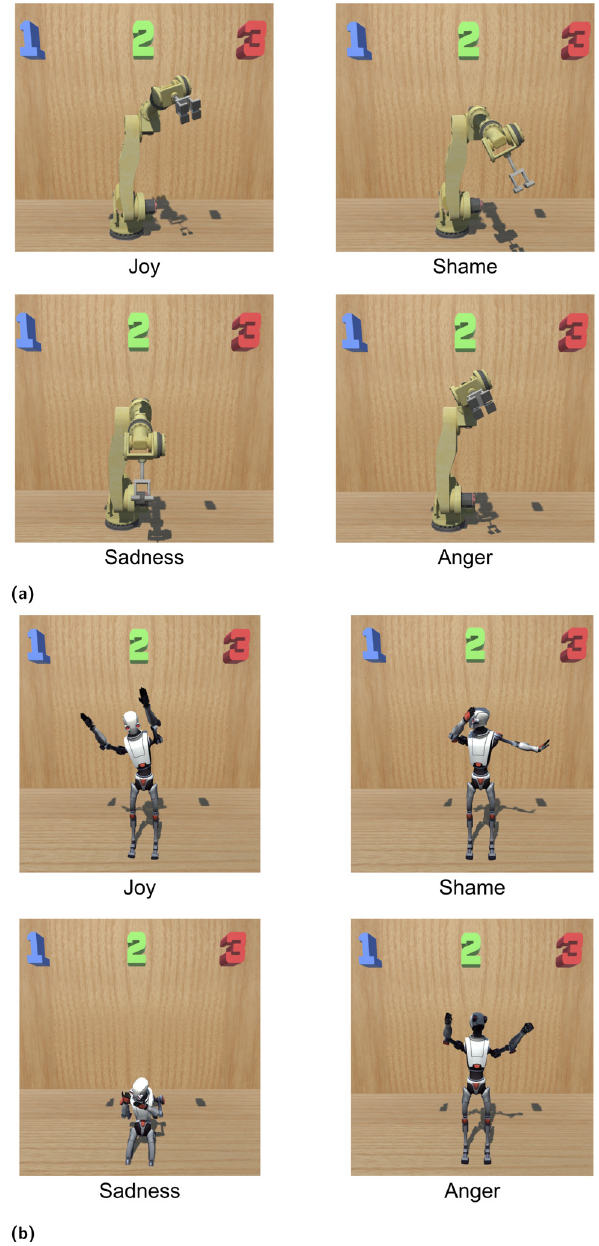
Figure 4: Example poses passed through during emotional gestures: ( a ) arm and ( b ) humanoid.